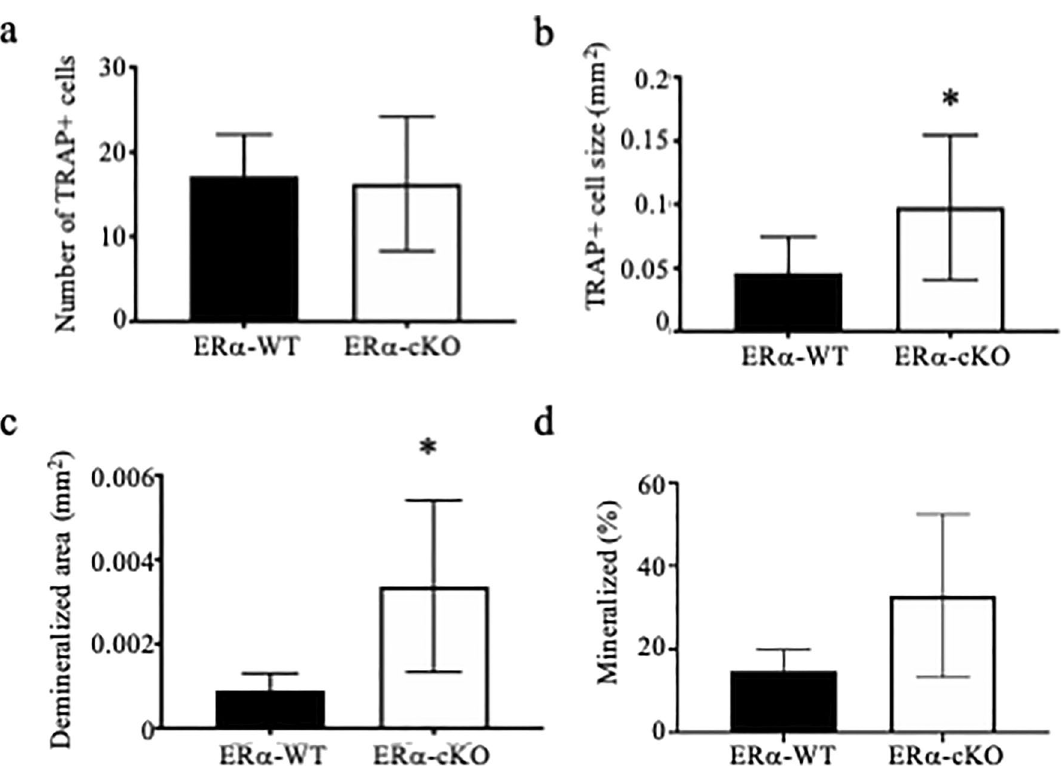
Figure 6. ERα-cKO mice have enhanced osteoclasts. ( A – C ) Bone marrow macrophages from ERα-WT and ERα-cKO animals were treated with M-CSF and RANKL to induce osteoclast differentiation. ( A ) average number and ( B ) average size of TRAP positive multinuclear cells and ( C ) average size of demineralized area. ( D ) Mesenchymal bone marrow cells were grown to confluency and induced to differentiate with the addition of ascorbic acid. Von Kossa assay was performed to measure percent mineralization of mesenchymal cells from ERα-WT and ERα-cKO animals. *Significantly different from